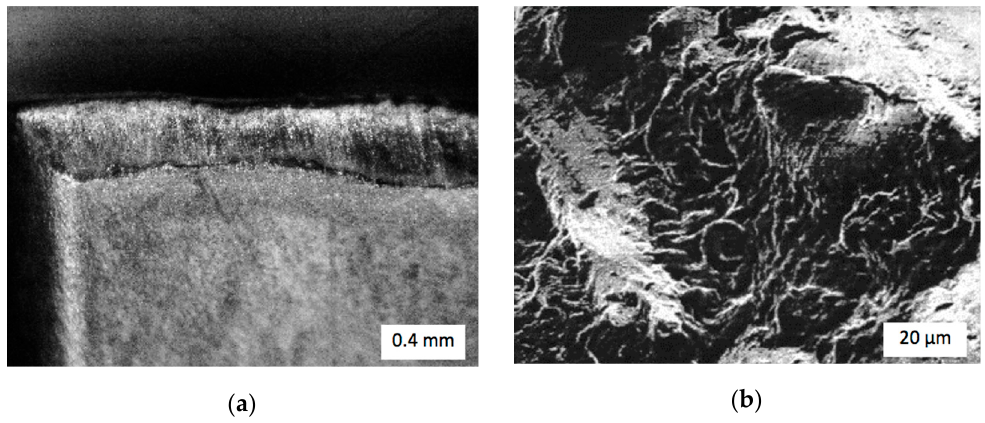
Figure 10. Flank wear of WolCar cutting inserts: ( a ) Photo; ( b ) SEM image. Neither larger cracks nor detachments were found in the WolCar worn surface layer.